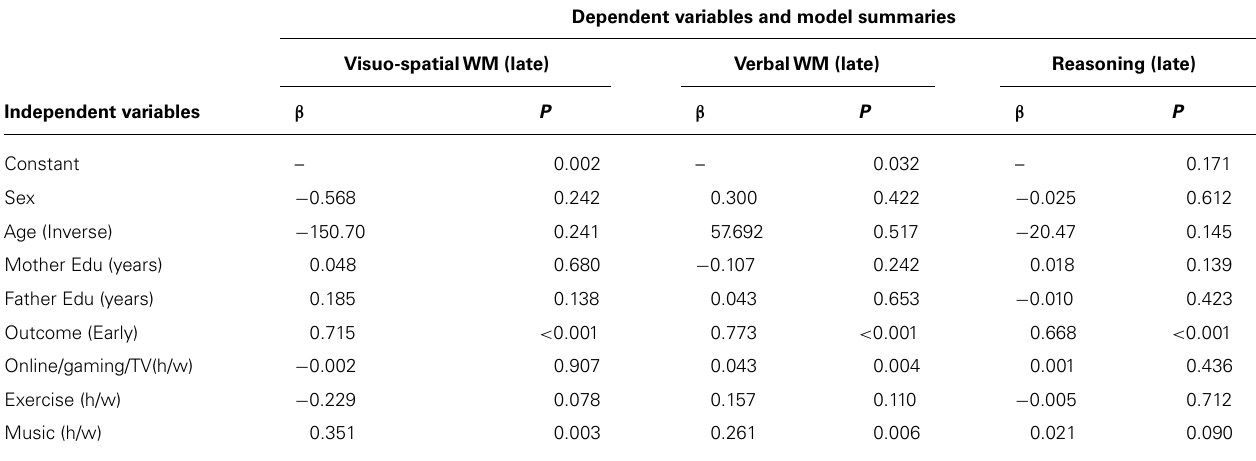
independent variables) for the primary outcomes plotted according to music training category. Error bars represent standard error of the mean (SEM).